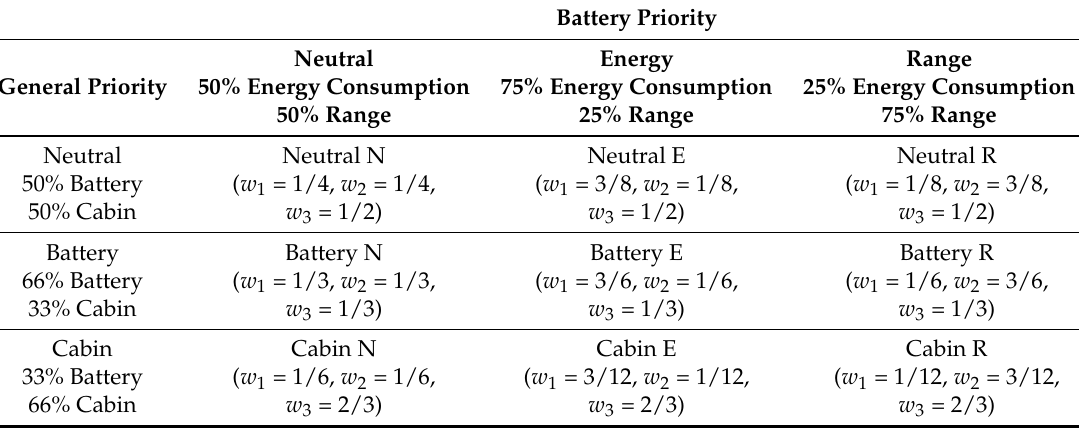
Table 7. The weighting factors used when optimisation priority is either neutral, battery weighted, or cabin